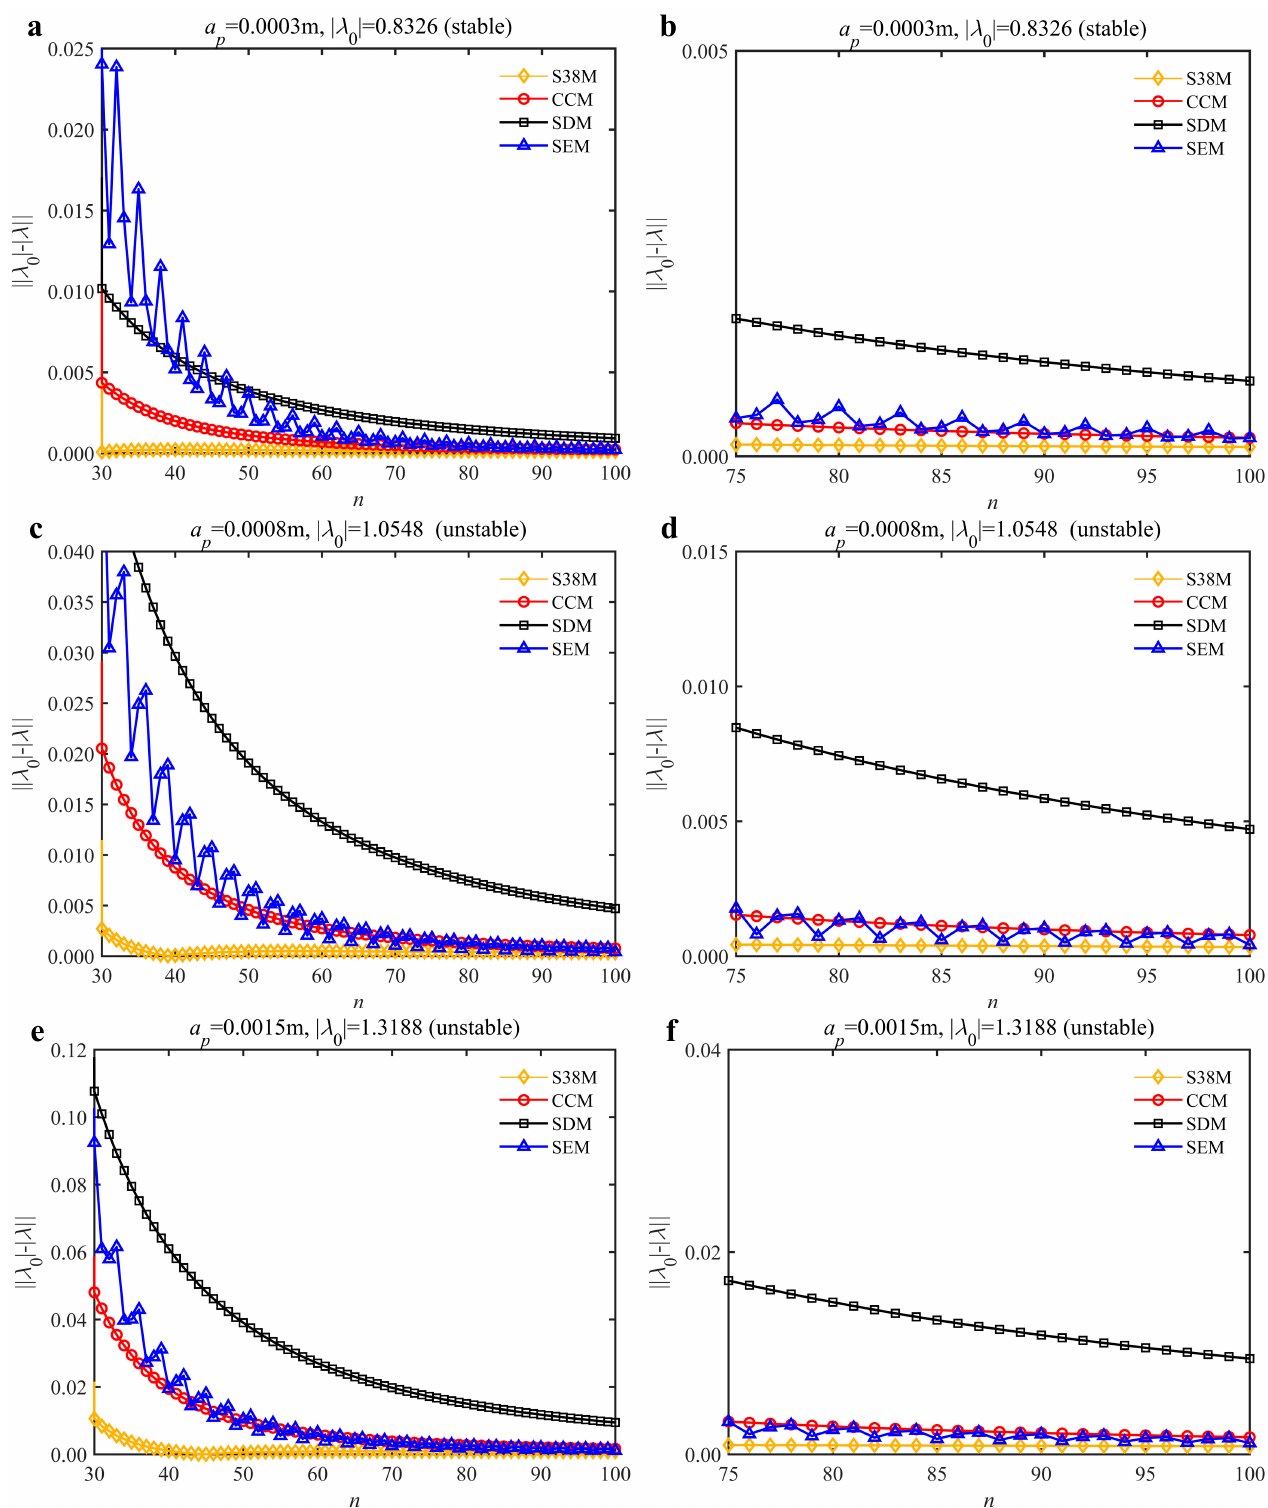
Figure 7. Convergence rate comparisons of the S38M, CCM, SDM, and SEM when v = 8000 rpm and a / D = 1. ( a ) a p = 0.0003 m and n ∈ [30,100]; ( b ) a p = 0.0003 m and n ∈ [75,100]; ( c ) a p = 0.0008 m and n ∈ [30,100]; ( d ) a p = 0.0008 m and n ∈ [75,100]; ( e ) a p = 0.0015 m and n ∈ [30,100]; ( f ) a p = 0.0015 m and n ∈ [75,100].